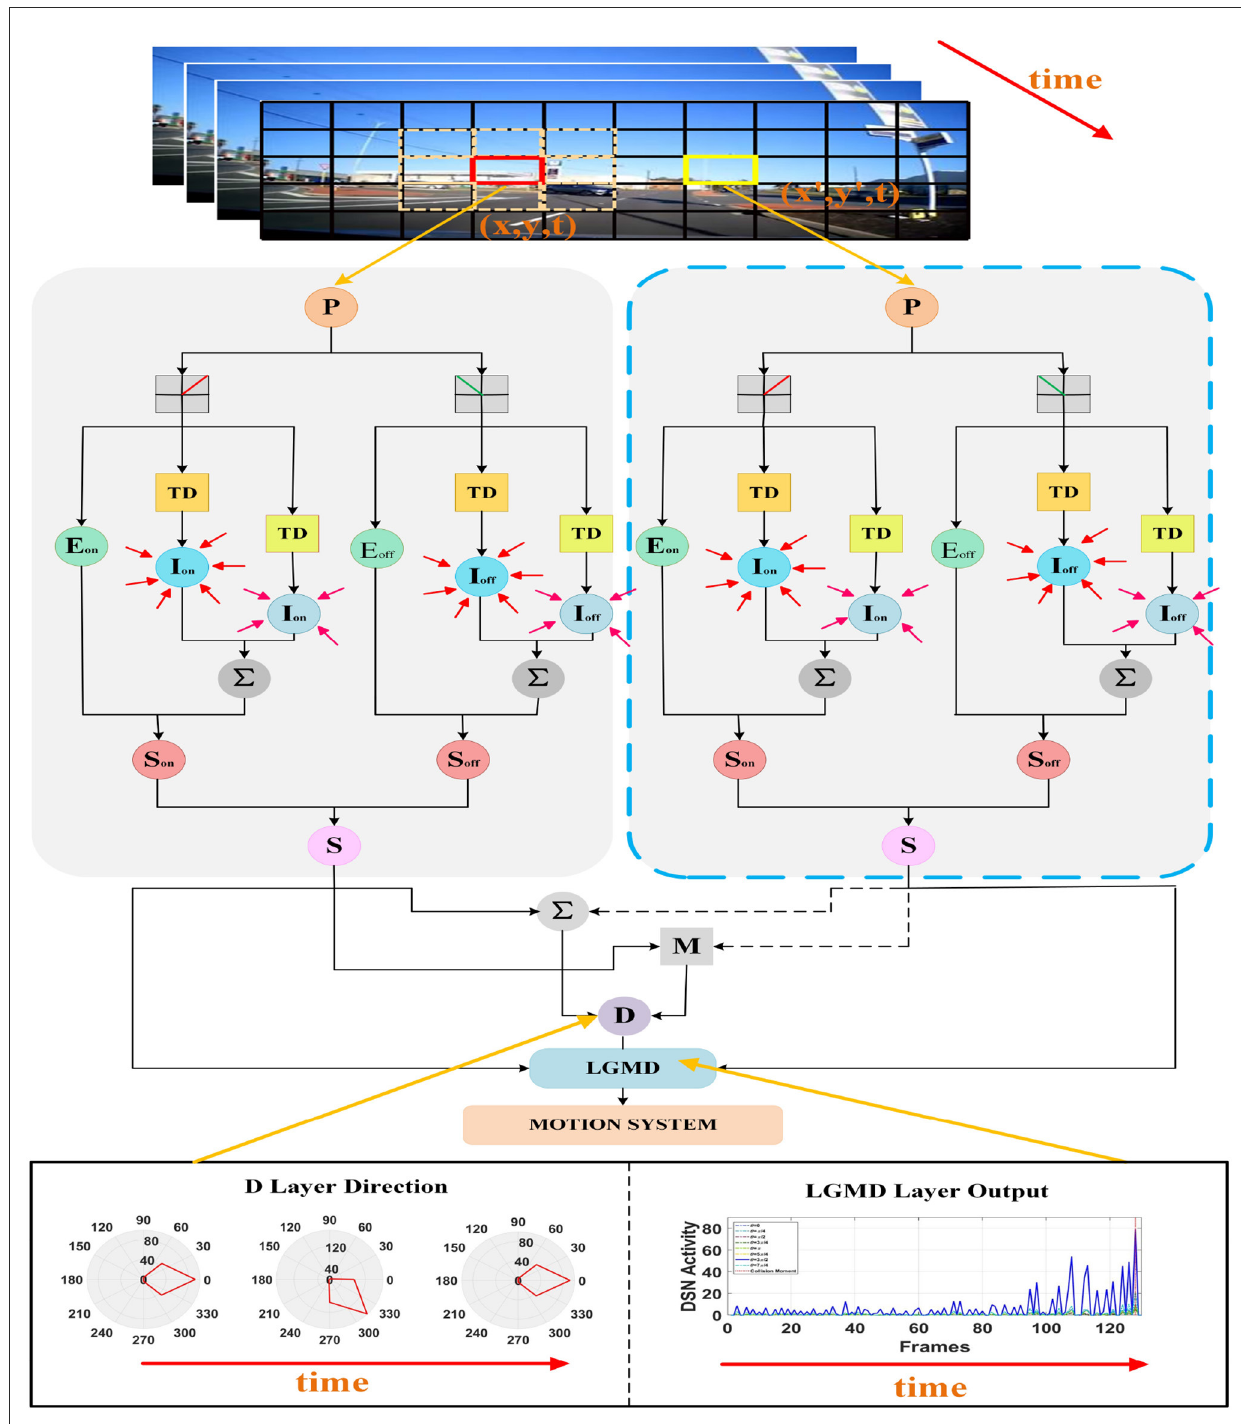
FIGURE2 Schematic illustration of the proposed DFLGMD neural network. DFLGMD neural network is composed of photoreceptor, ON/OFF channel, excitability, inhibition, summing cells, directionally selective neuron, and single-cell LGMD cells. For clear illustration, only two photoreceptors at different positions and corresponding downstream processing are